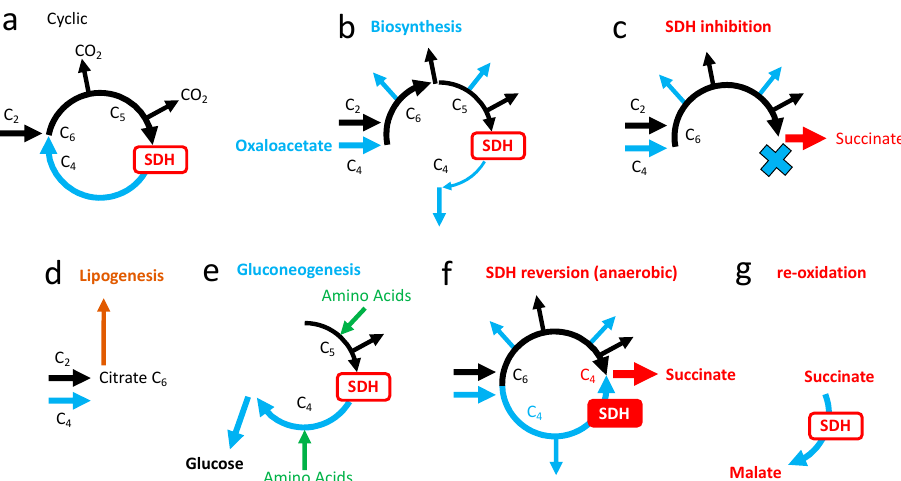
Figure 9. Simplified representation of different modes for the TCA cycle relevant here. Only the fate of carbons is taken into consideration (no representation for redox or phosphorylation reactions).